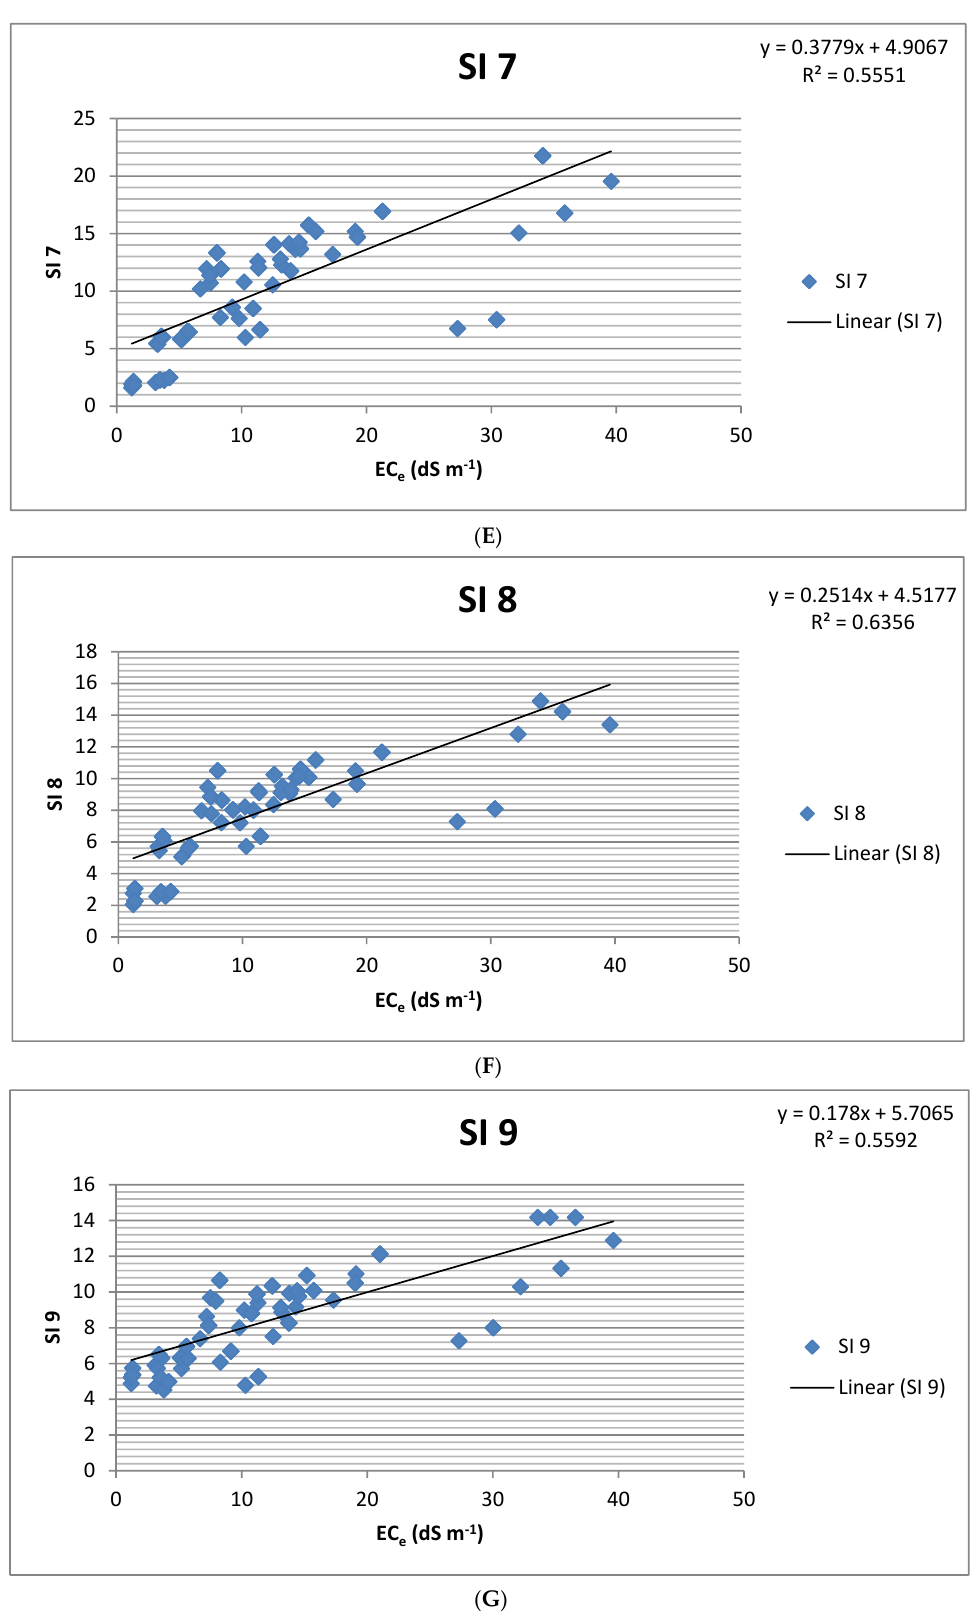
Figure 5. Linear regression equations and coefficients of determination between laboratory soil salinity (EC e ) and soil salinity indices (SI S ): ( A ) = SI 1; ( B ) = SI 2; ( C ) = SI 5; ( D ) = SI 6; ( E ) = SI 7; ( F ) = SI 8 and ( G ) = SI 9.